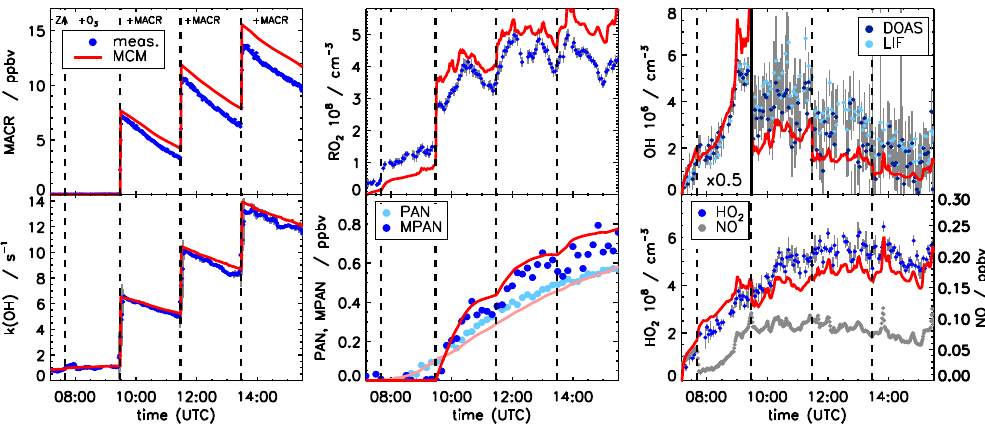
Figure 1. Measured and modelled time series of MACR, k (OH), PAN, MPAN, RO 2 , HO 2 , OH, and NO for the experiment on 11 August 2011. OH concentrations prior to the addition of MACR (“ZA”, “+O 3 ”) are scaled by a factor of 0.5. Model calculations applying MCM underestimate OH concentrations. Measured and modelled HO 2 concentrations include a small fraction of RO 2 radicals, which show up as an interference in the HO 2 detection (less than 5% of the entire concentration). RO 2 radical concentrations shown here do not include the class of acyl peroxy radicals, which cannot be detected by the